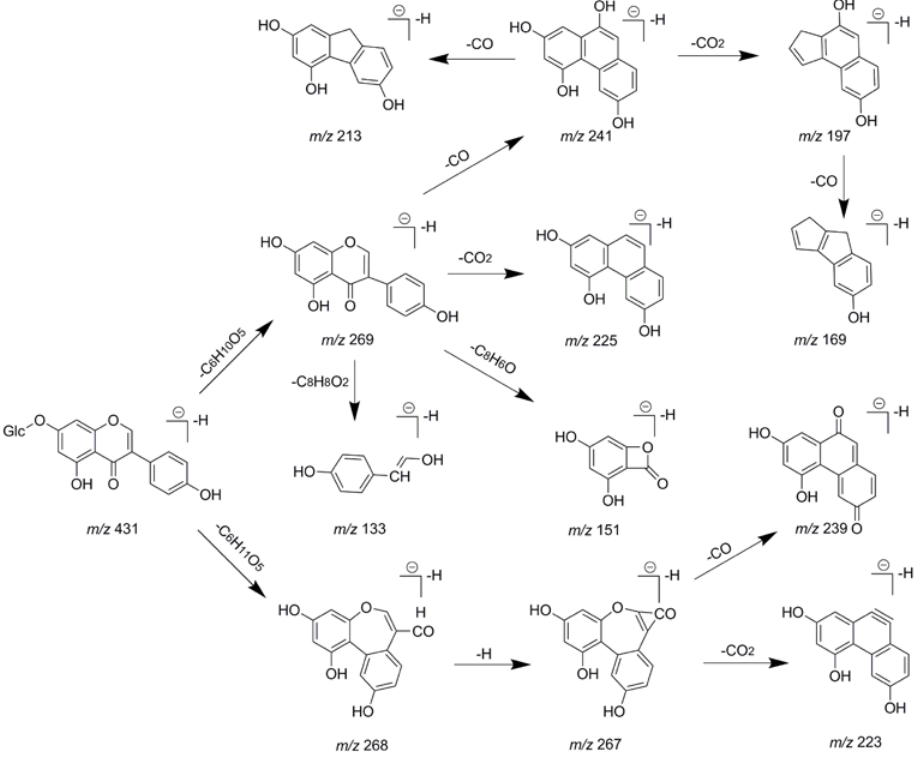
Figure 4. The fragment behaviors of genistin in negative ion mode.